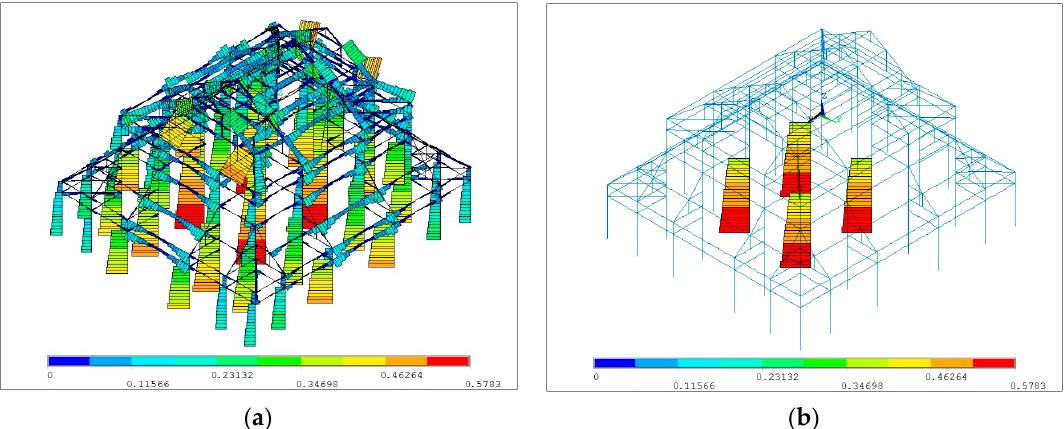
Figure 11. ( a ) The results of component importance analysis for the Main Hall of the Tomb of Yu; ( b ) the critical components of the Main Hall of the Tomb of Yu.